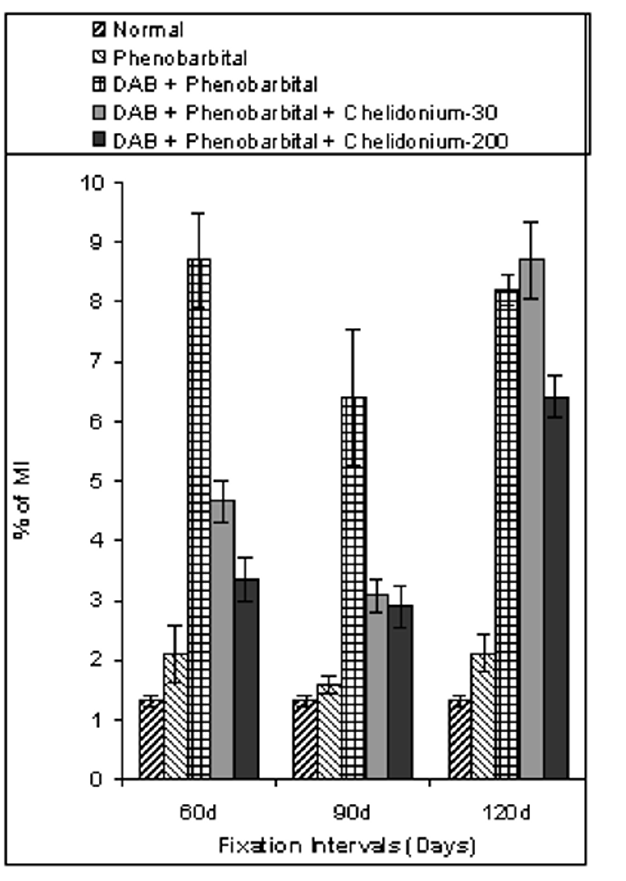
Figure 5 Showing % of SHA in different series of mice at different fixa- tion